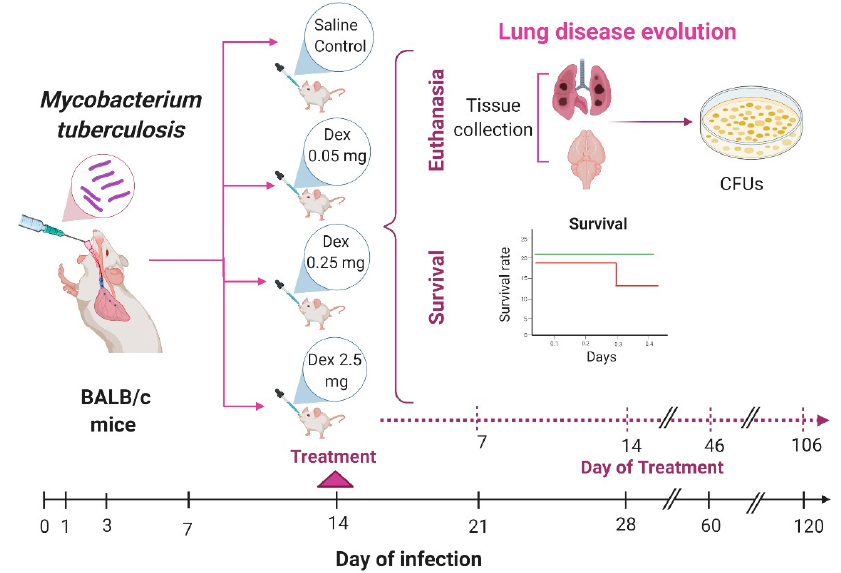
Figure 10. Study design workflow to evaluate the IN DEX treatment on lung disease evolution. BALB/c mice, 8 weeks of age, were infected with 2.5 × 10 5 live bacilli. On day 14, the treatment with IN DEX started. We tried three different DEX doses: L/DEX (0.05 mg/kg BW), M/DEX (0.25 mg/kg BW) and H/DEX (2.5 mg/kg BW) by IN route; a control group received saline solution. On days 21, 28, 60, and 120 post-infection animals were euthanized, and the brain and lungs were collected to determine bacillary loads. During the complete experiment, we evaluated the survival of the animals. The samples for each experimental age group were run separately. (Created with BioRender.com, accessed on 20 May 2021).